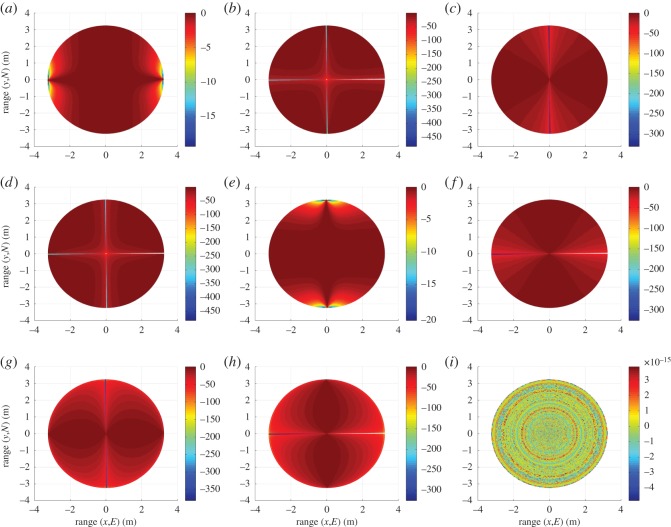
Polarization mismatch (epol) (dB) profiles for each unit dipole pair: (a) x^p^, (b) y^p^, (c) z^p^, (d) x^q^, (e) y^q^, (f) z^q^, (g) x^r^, (h) y^r^ and (i) z^r^.